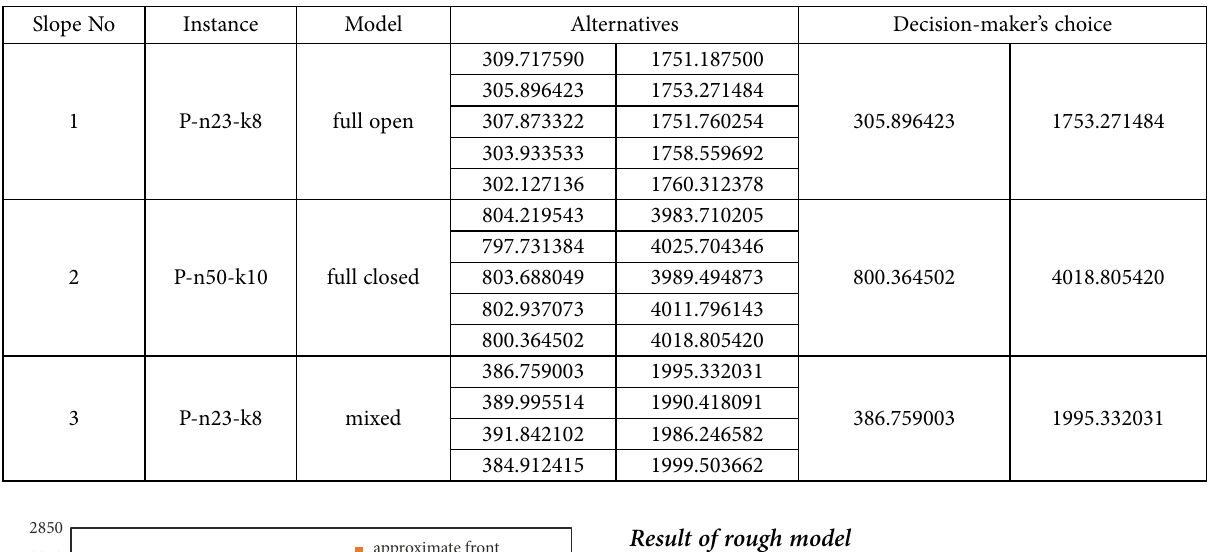
Table 4. Results of VIKOR method after applying on some set of Pareto optimal solutions